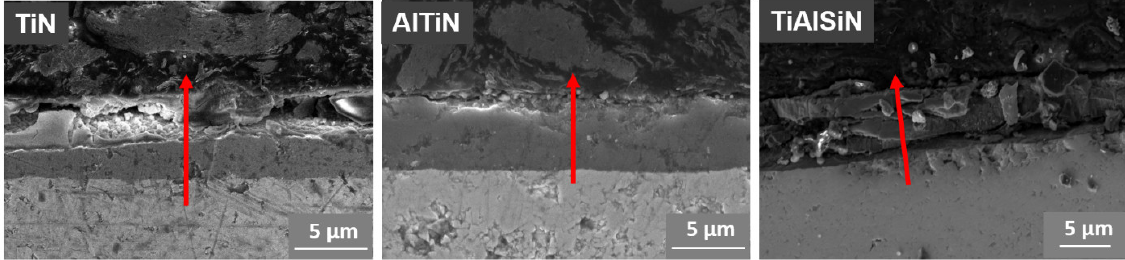
Figure 8. Cross-sectional SEM images of TiN, TiN/AlTiN and TiAlSiN coatings.